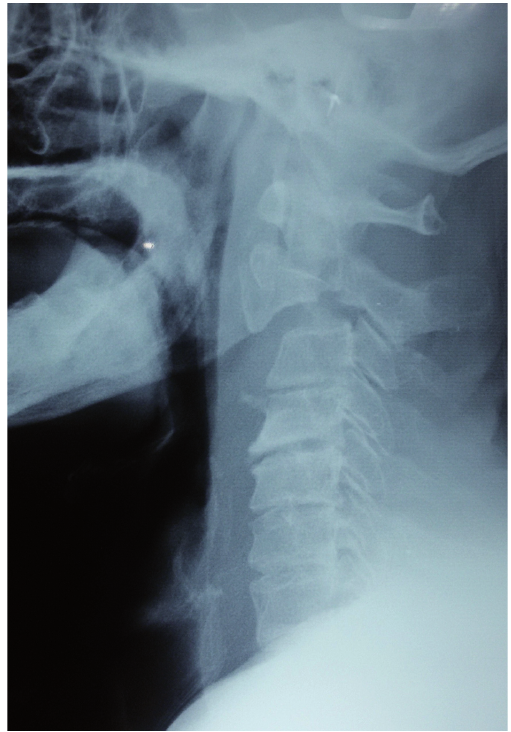
Figure 5. CT spine showing projection of screw through lateral mass of C3.